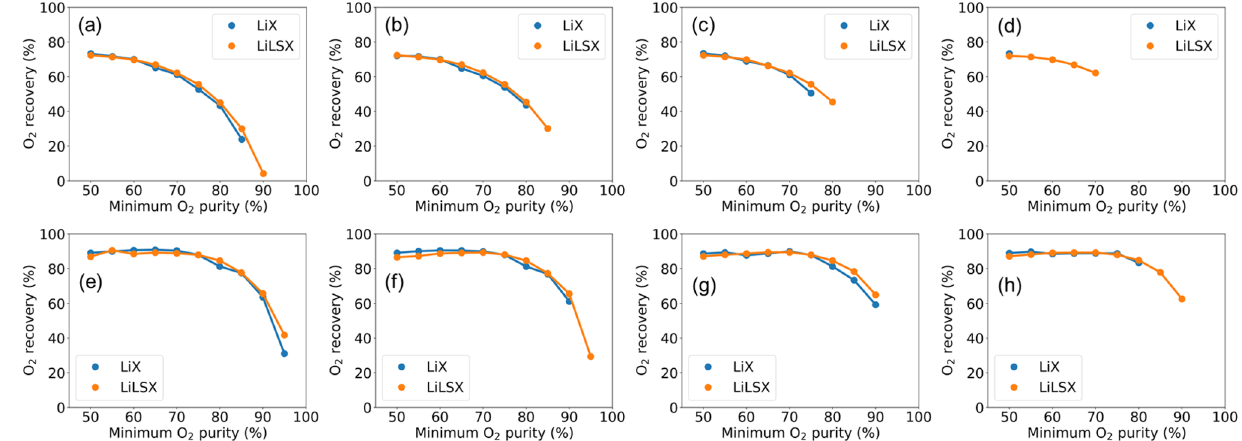
Figure 8. Purity-recovery Pareto frontier obtained using optimization-based analysis. ( a – d ) PSA with minimum production ( a ) 1, ( b ) 5, ( c ) 10 and ( d ) 15 L/min. ( e – h ) PVSA with minimum production ( e ) 1, ( f ) 5, ( g ) 10 and ( h ) 15